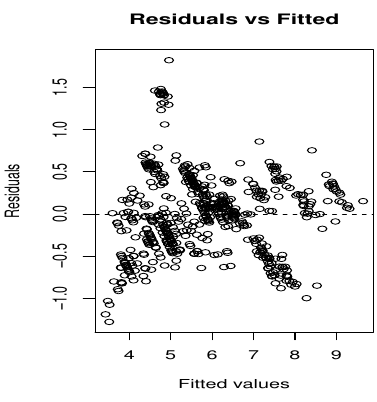
Figure 7. The residuals versus the estimated responses of the GPP